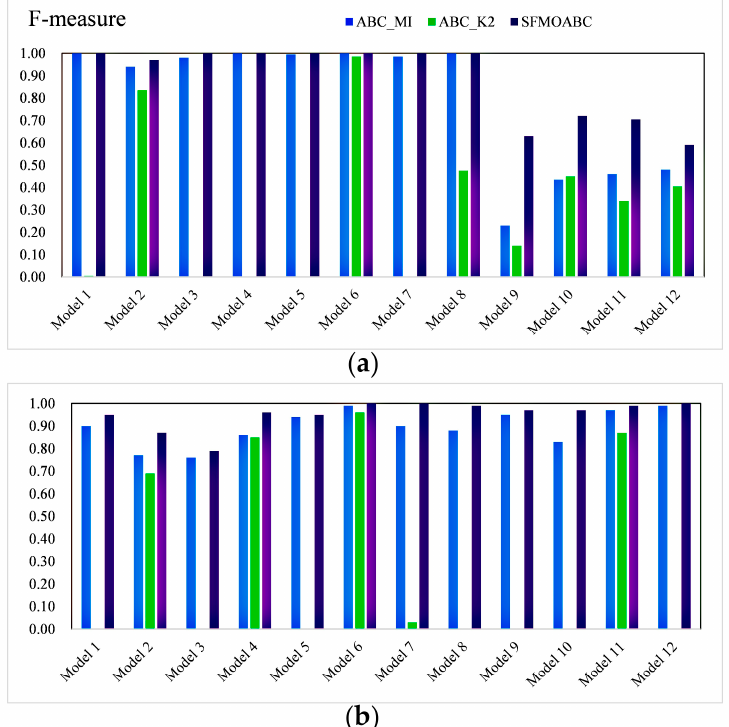
Figure 6. F-measure of single-objective ABC algorithms: ( a ) F-measure on the small-scale datasets; ( b ) F-measure on the large-scale datasets.